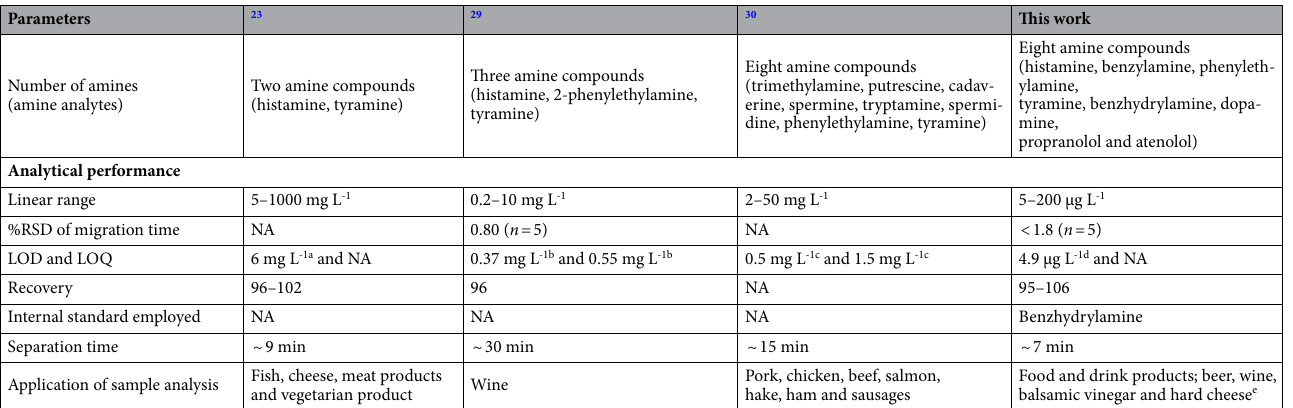
Table 2. Previous methods for tyramine analysis using CE-UV detection with number and types of amine, the analytical performance (linear range, %RSD of migration time, LOD and LOQ and recovery), internal standard employed, separation time and application of sample analysis. NA Not available. a Calculation of LOD and LOQ not shown. b LOD and LOQ were calculated by QC Expert 2.5 (IUPAC method). c LOD and LOQ were calculated from 3 × SD and 10 × SD of the blank signal. d LOD was calculated from 3 × (SD of intercept)/ slope of calibration line. e Extraction before analysis (Supplementary Information